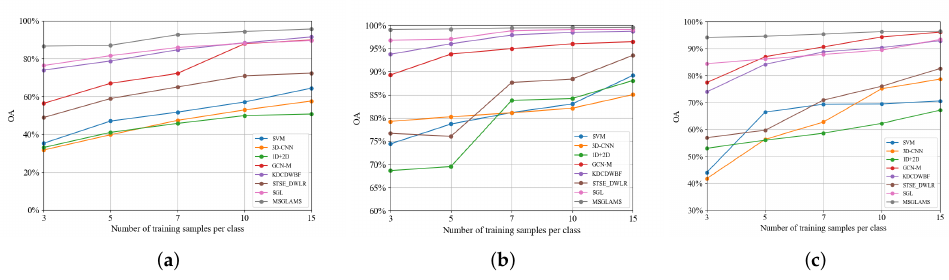
Figure 11. Classification accuracy values of different numbers of labeled samples on three datasets.